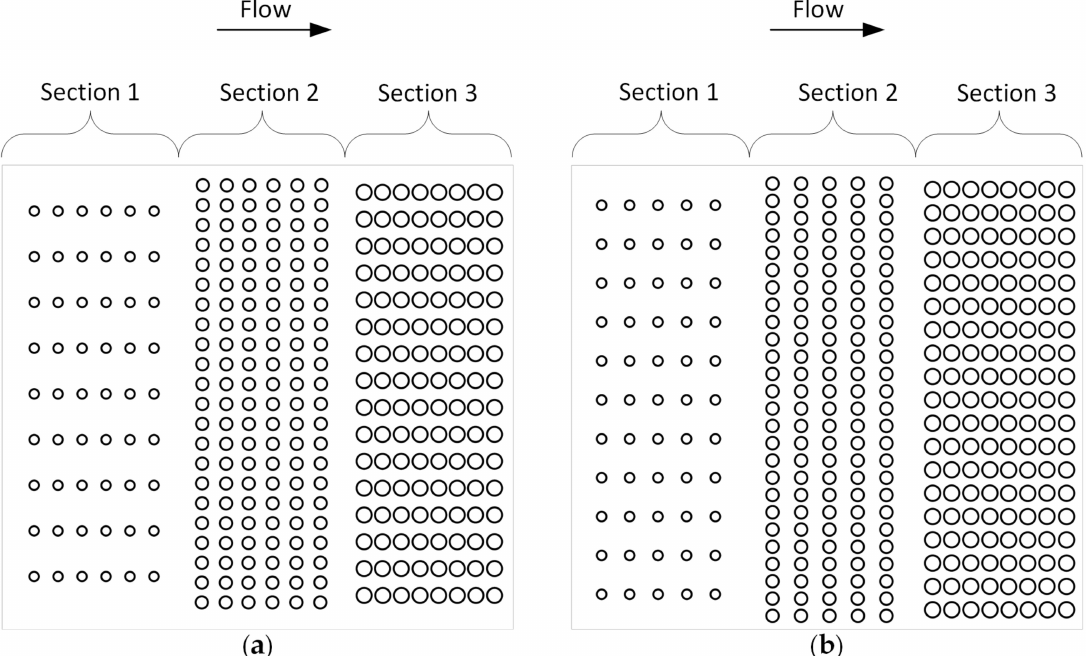
Figure 5. Sketch of the manufactured ba ffl es showing the hole distribution on the ba ffl e: solidity ratio decreases in the flow direction ( a ) Design 2; ( b ) Design